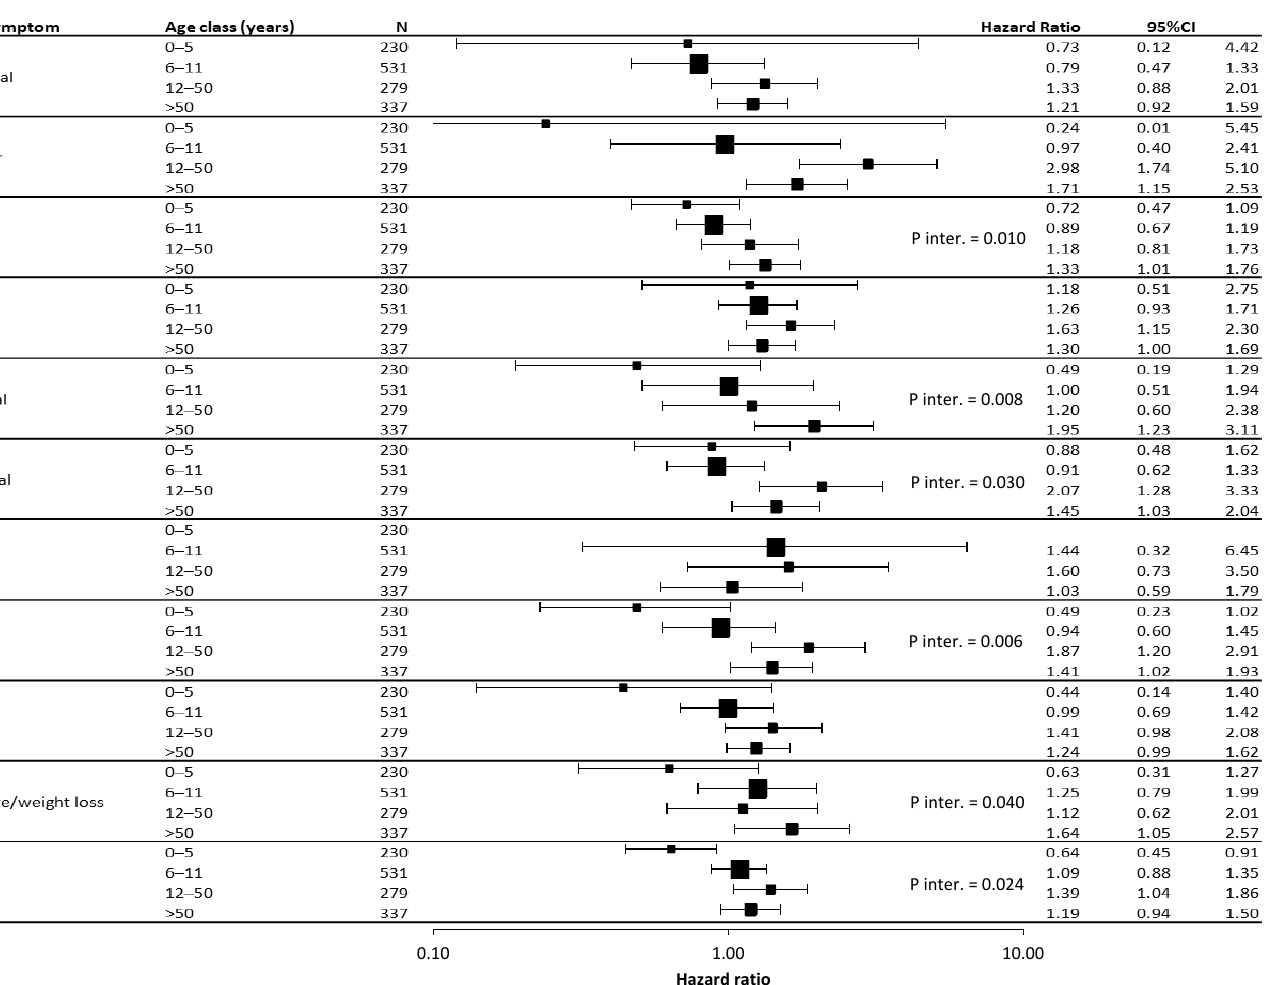
Figure 3. Forest plot of the risk estimate (hazard ratio, HR) of post-COVID-19 symptoms for females vs. males in each symptom category, stratified by age group. HRs are adjusted for age. Abbreviations: p -inter., p -value for the sex × age interaction term in the Cox model. Notes: HR for sensory symptoms in the 0–5 year group was not estimable because of a lack of events; data are from all of the surveys collected.